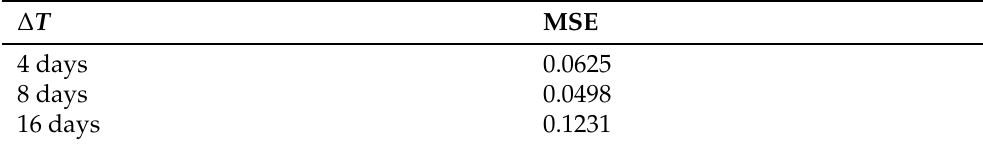
Table 4. Sensitivity analysis: impact of the width of the integration time